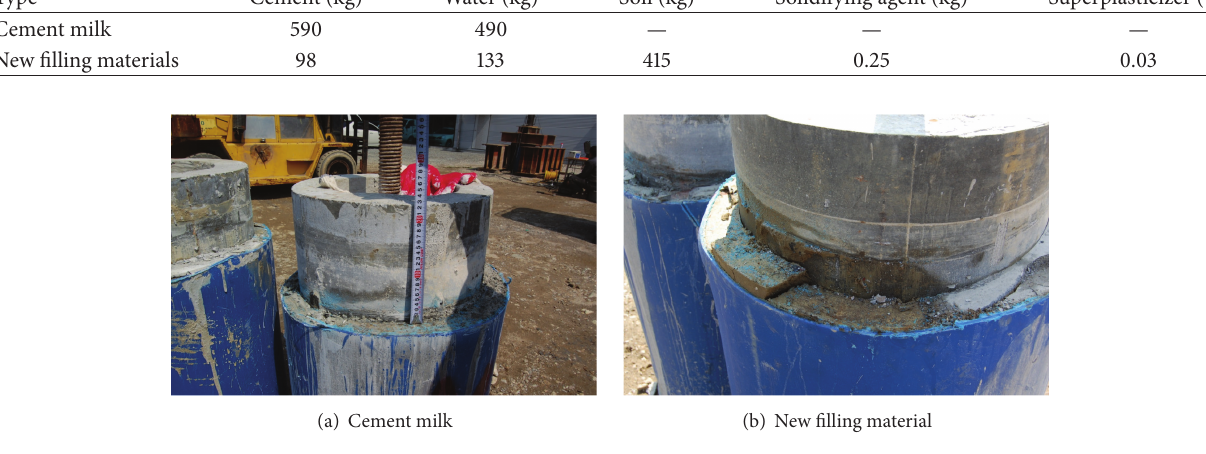
Figure 8: Failure shape using a pull-out test.